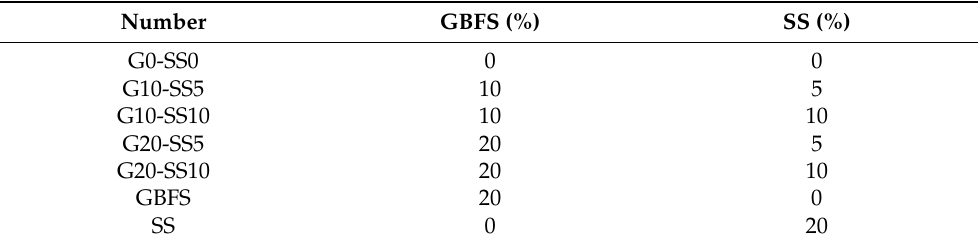
Table 4. Compound modification tests for the coral aggregate.